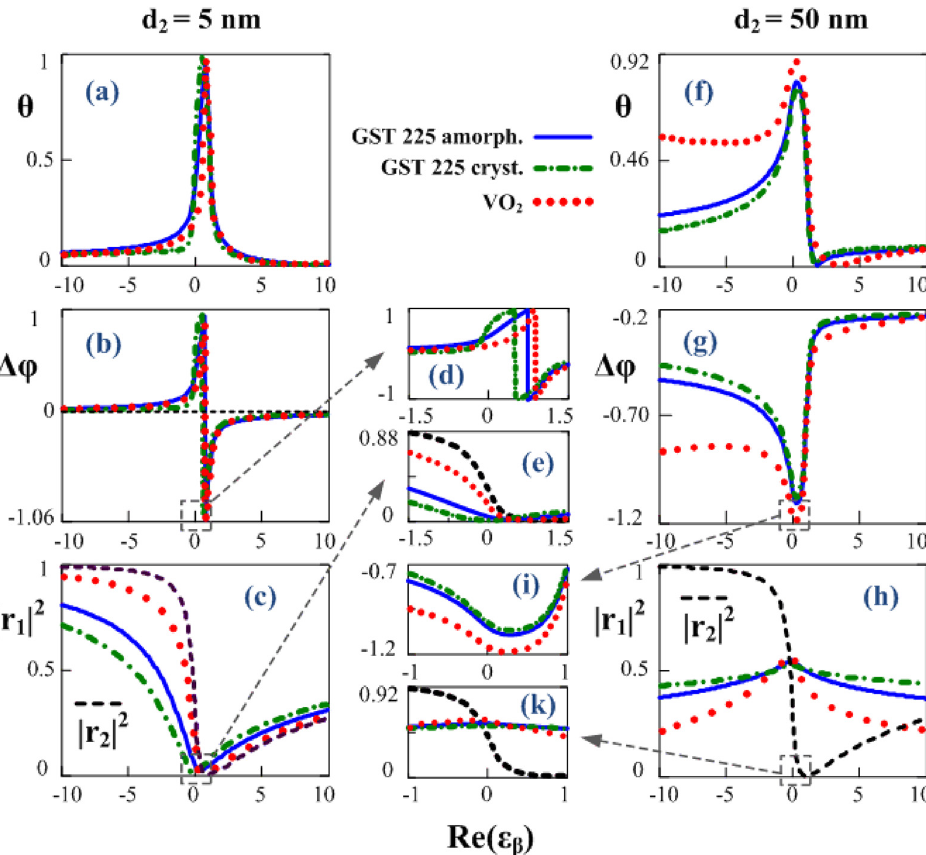
Fig. 5. Dependences of angle u (a, f), PSD of the re fl ected waves (b, d, g, i) and corresponding energy re fl ection coef fi cients (c, e, h, k) on parameter e 0 b for various PCMs (amorphous and crystalline GST 225, VO 2 ) as the main layer material. The values of parameters are: d 2 = 5nm (a – e), 50 nm (f – k). The values of parameters for all the graphs are: c = 0, l = 650nm, d 1,3,4 =0, e 00 b ¼ 0 : 2 , m b = 1. d, e, i, k detail the corresponding graphs for the cases of optimal parameters. The black horizontal dashed line in (b) corresponds to the condition D ’ = 0. Parameter e 0 b is used as the abscissa axis for all the